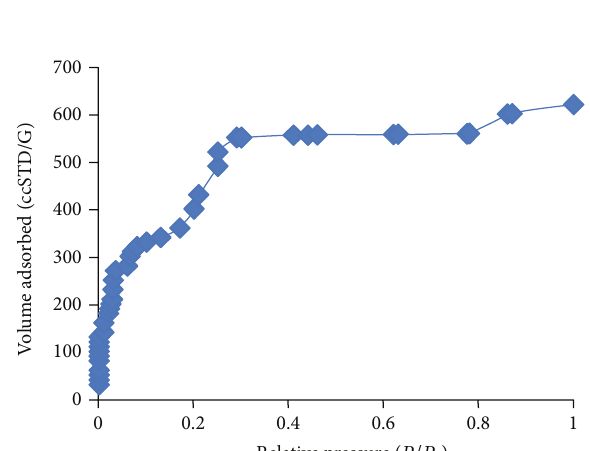
Figure 3: XRD patterns of SBA-3.